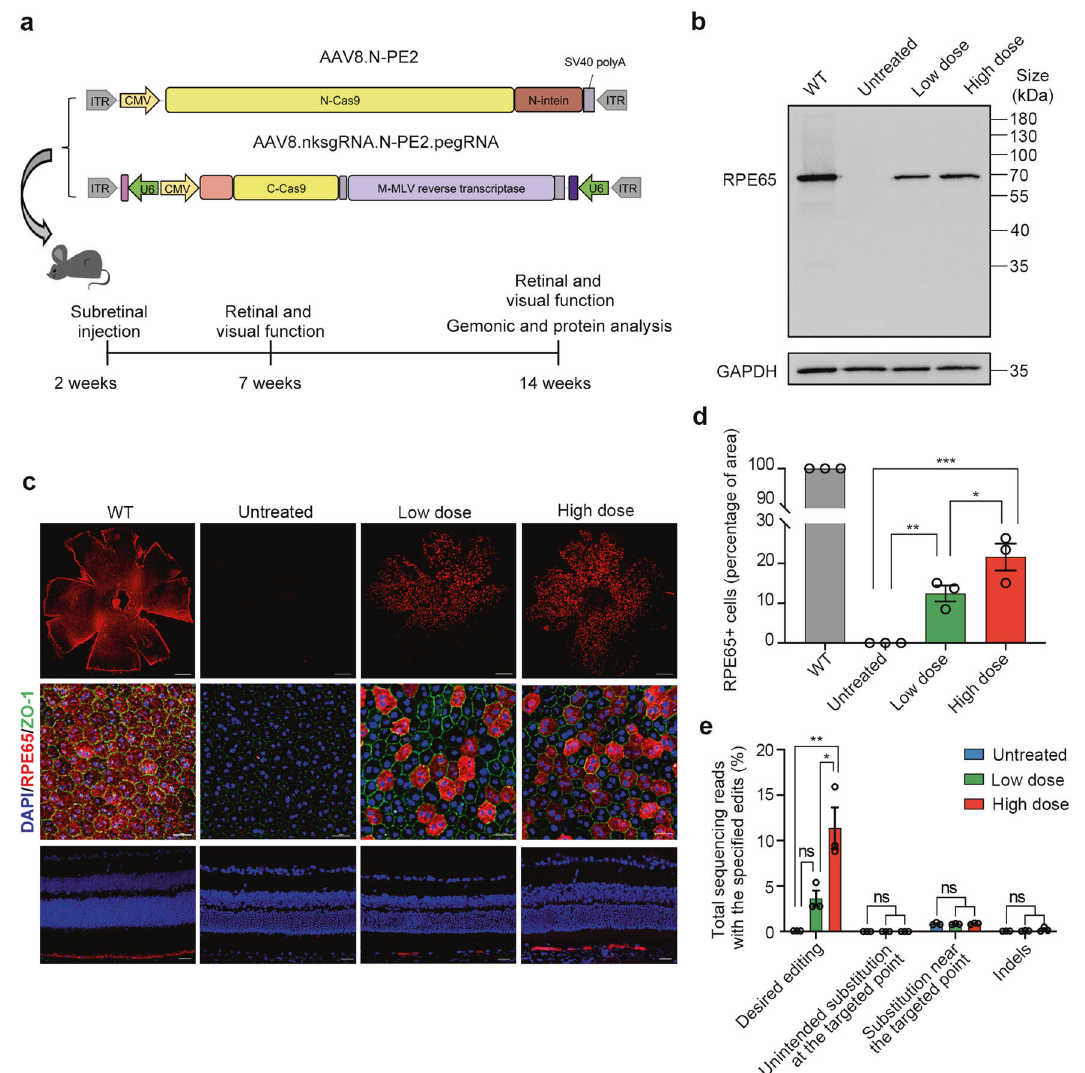
Fig. 3 Subretinal delivery of dual-AAV8 split-PE3 corrects mutation and restores expression of Rpe65 in rd12 mice. a Schematic of the AAV vector genomes for subretinal delivery (top) and timeline of the experimental setup (bottom). Two-week-old rd12 mice were subretinally injected with a total of 3 × 10 9 or 1 × 10 10 GC/eye AAV8 (with the two vectors at 1:1 ratio), referred to as the low dose and high doses, respectively. After 5 and 12 weeks, retinal and visual function were assessed. After 12 weeks, the RPE tissue was harvested for genomic and protein analysis. b Western blot analysis to detect RPE65 (65 kDa) expression in mouse RPE tissue lysate 12 weeks post injection. GAPDH (36 kDa) was used as a loading control. c Immuno fl uorescence analysis of representative RPE fl atmounts ( fi rst row in low magni fi cation and second row in high magni fi cation) and eye cross sections (third row) of treated mice. Red indicates RPE65, blue indicates DAPI, and green indicates ZO-1 (a protein marker for tight junctions). Scale bars, 500 μ m for fl atmounts in low magni fi cation; 25 μ m for fl atmounts in high magni fi cation and eye cross sections. d Quanti fi cation of RPE65 + cells from the low magni fi cation images ( n = 3 in each group) of the RPE fl atmounts based on immuno fl uorescence. Data are shown as mean ± SEM. One-way ANOVA with post-hoc Tukey ’ s multiple comparison tests. * p < 0.05, ** p < 0.01, *** p < 0.001. e Frequencies of desired and unintended edits in the rd12 locus in genomic DNA isolated from the RPE tissue of untreated, low-dose-treated, and high-dose-treated eyes ( n = 3 in each group). Data are shown as mean ± SEM. A 40-bp region centered on the pegRNA nicking site was used to assess substitutions near the targeted nucleotide. A 100-bp region centered on the pegRNA nicking site was used to assess indels. Data are mean ± SEM. One-way ANOVA with post-hoc Tukey ’ s multiple comparison tests. * p < 0.05, ** p < 0.01, ns nonsigni fi cant (Fig. 5a – c). Photoreceptor degeneration in the unedited area by UV light at any of the tested light intensities in untreated rd12 might be a factor because the ERG response was further mice (Fig. 5c). In the high-dose group, the rescue was more decreased in untreated rd12 mice. prominent, with the b- and a-wave amplitudes improved by 43.9% Visual function was tested in wild-type (WT) mice and treated and 51.9%, respectively, at the highest stimulus in scotopic ERG; and untreated rd12 mice using the visual cliff test, which depends 30.2% and 53.9% at the highest stimulus in green light photopic on animals ’ intrinsic propensity to avoid the deep side of a visual ERG; and 39.7% and 49.7% at the highest stimulus in UV light cliff fi eld (Fig. 5d). 18 The cumulative time the mice spent in the photopic ERG. At 12 weeks after injection, we observed a slight decrease in scotopic and photopic ERG rescue in both the high- safe and unsafe zones was recorded. The results at 5 weeks post and low-dose groups compared to 5 weeks post injection injection showed that untreated rd12 mice had no preference for